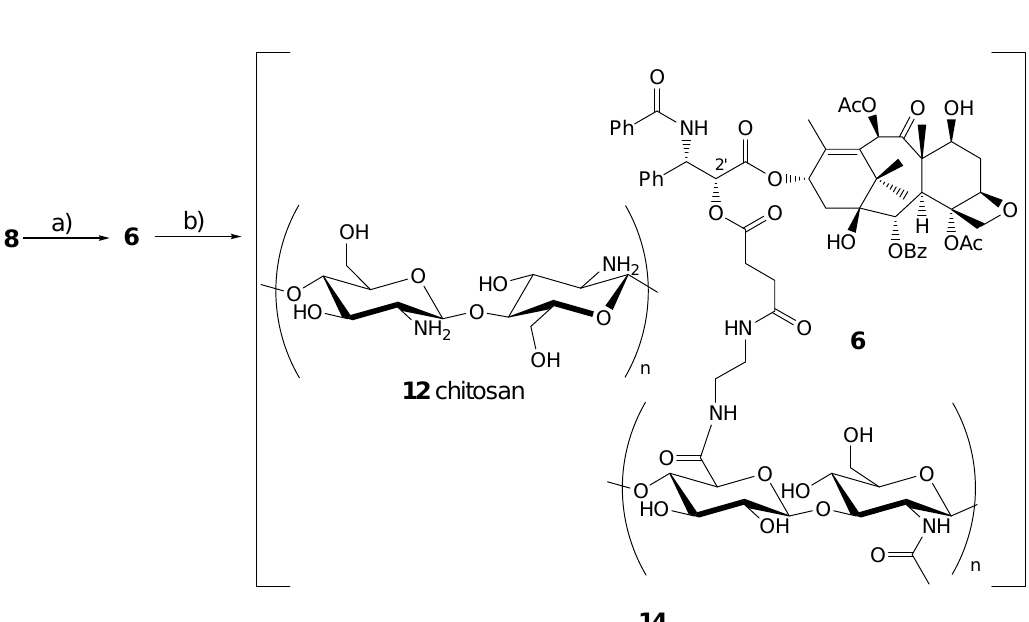
Scheme 3. Preparation of Biomaterial